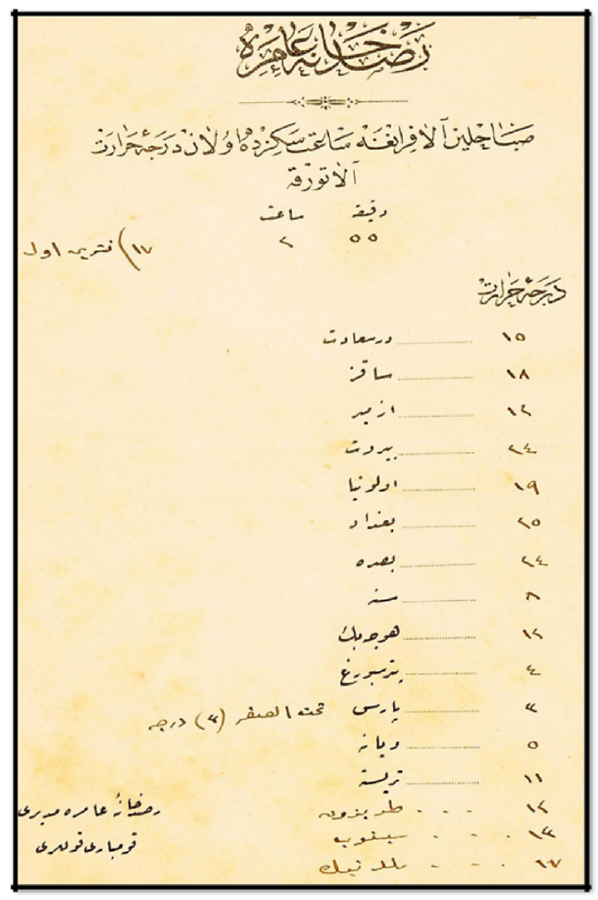
Figure 6. A meteorological report (dated 13 April 1893) sent to Yıldız Palace (a residence of the sultan and his court in the late 19th